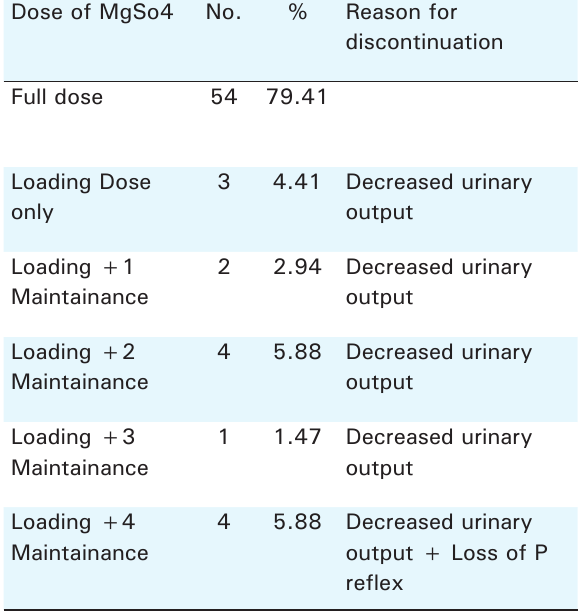
Table 4. Dose of Magnesium Sulphate